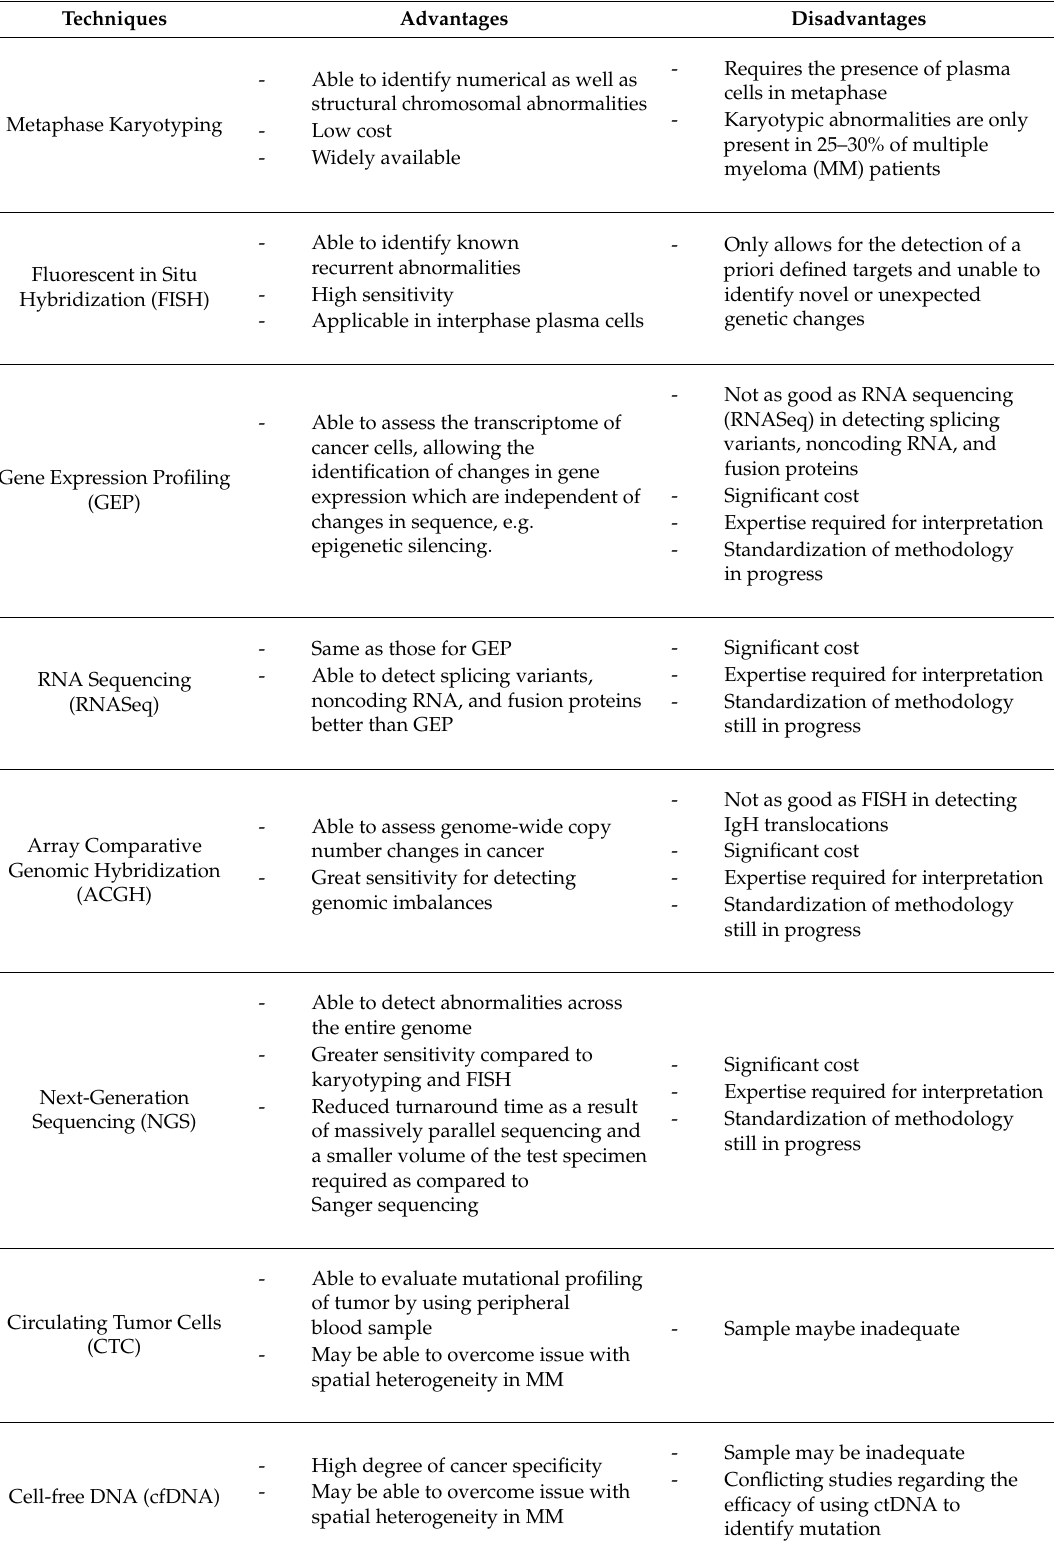
Table 1. Advantages and disadvantages of different genomic